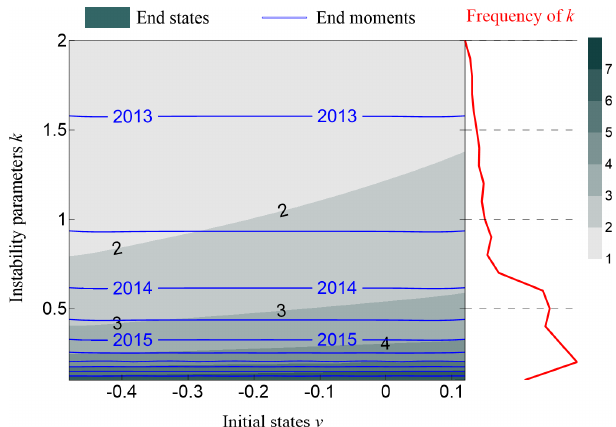
Figure 10. Variation end state and end moment, with the initial state parameter v (horizontal ordinate) and instability parameter k (verti- cal coordinate). The red line on the right-hand side shows the prob- ability distribution of instability parameter k